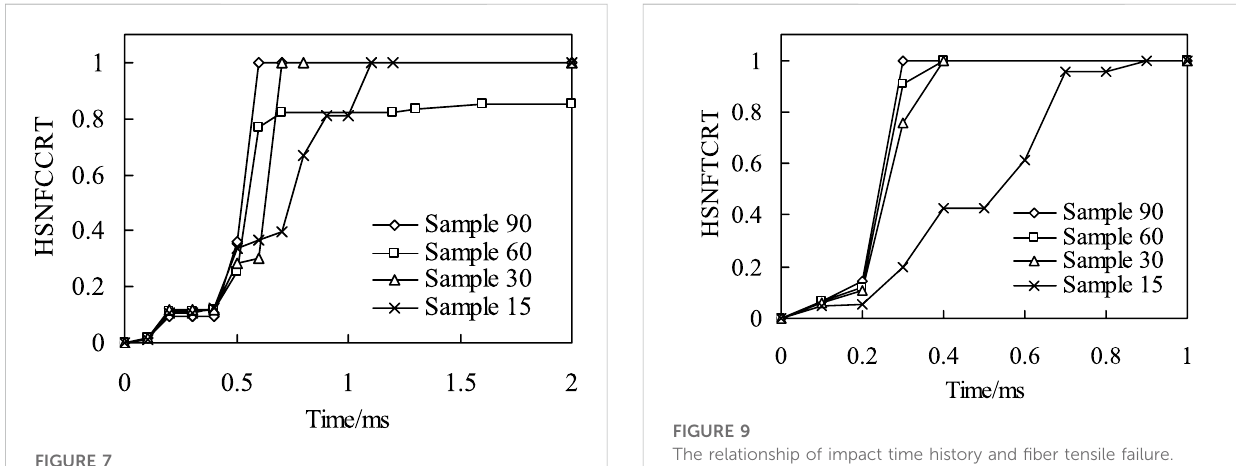
FIGURE 7 The relationship of impact time history and fi ber compression failure.